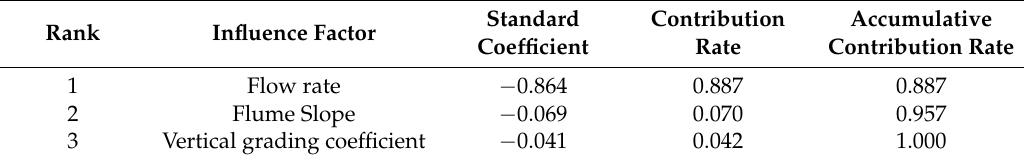
Table 2. Contribution rates of experimental factors on starting